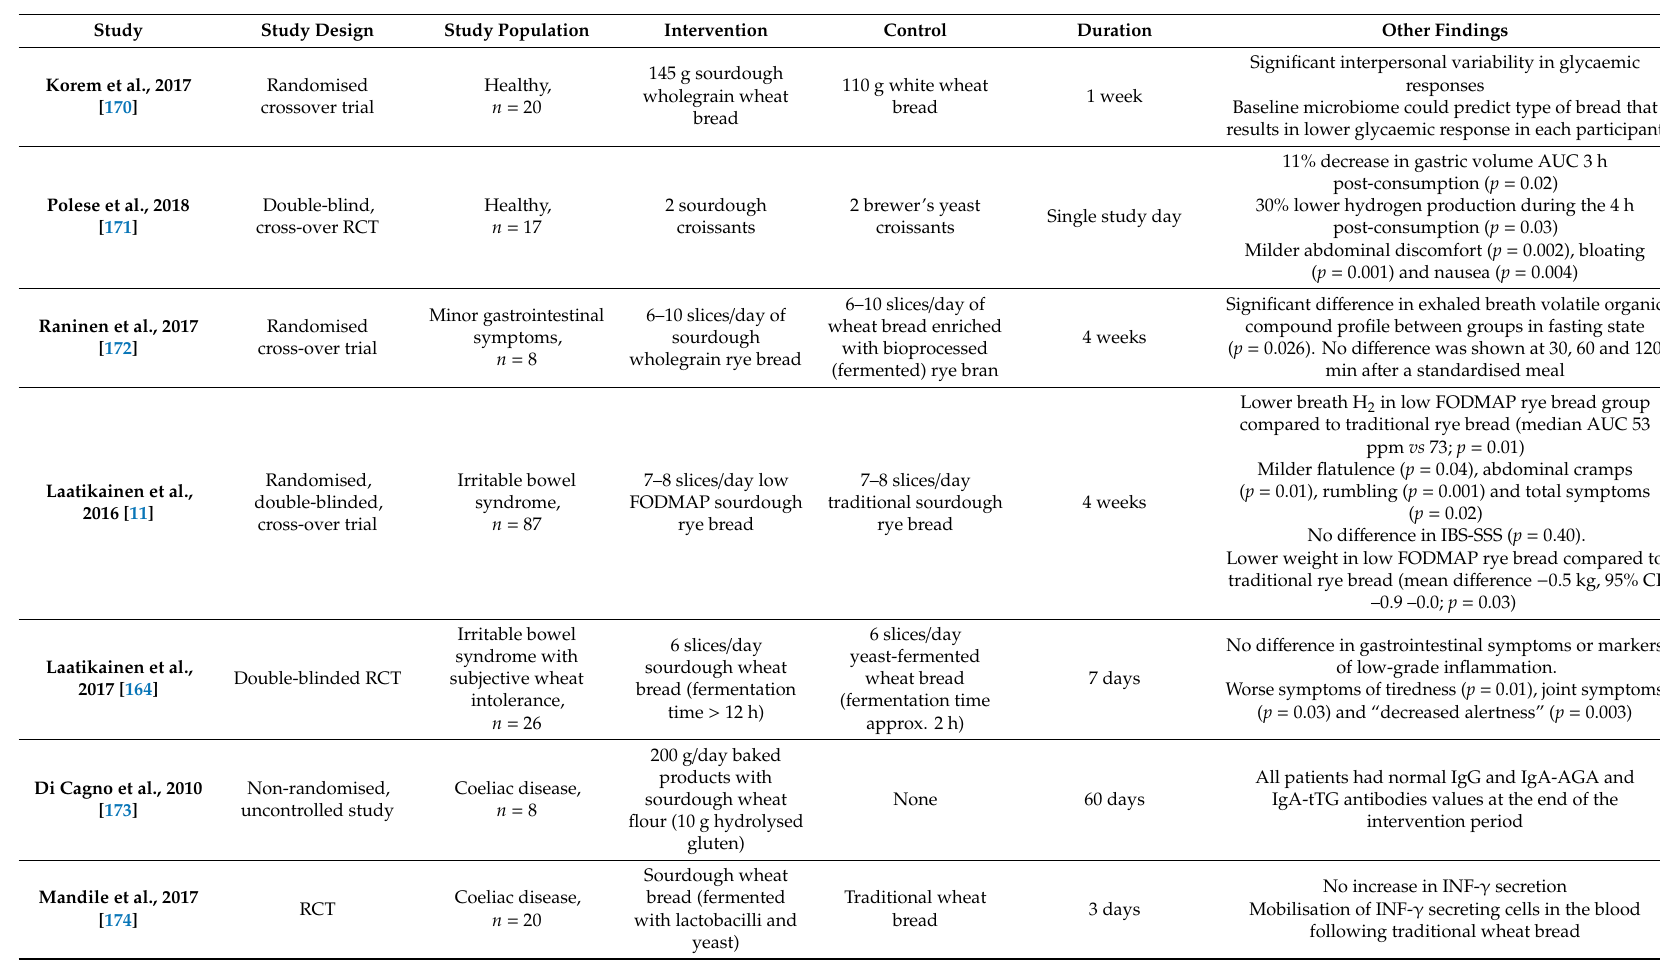
Table 4. Summary of interventions studies investigating the impact of sourdough bread in gastrointestinal health and